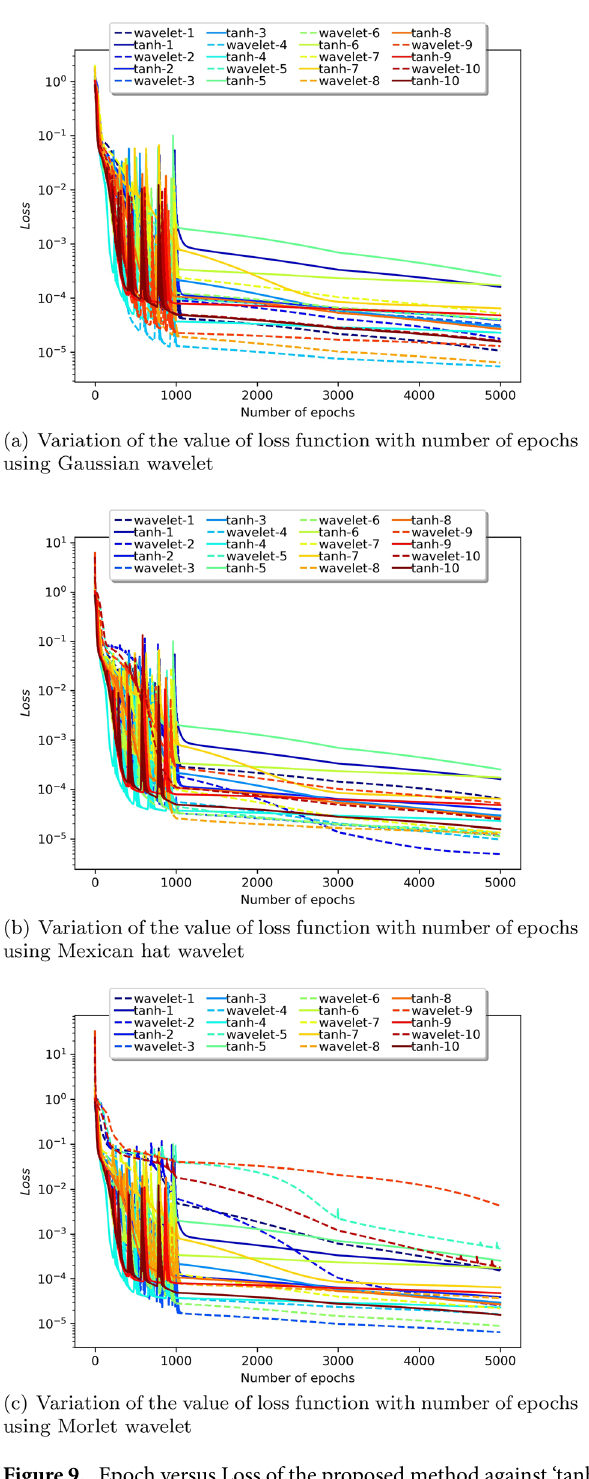
Figure 9. Epoch versus Loss of the proposed method against ‘tanh’ over 10 instances for the Blasius